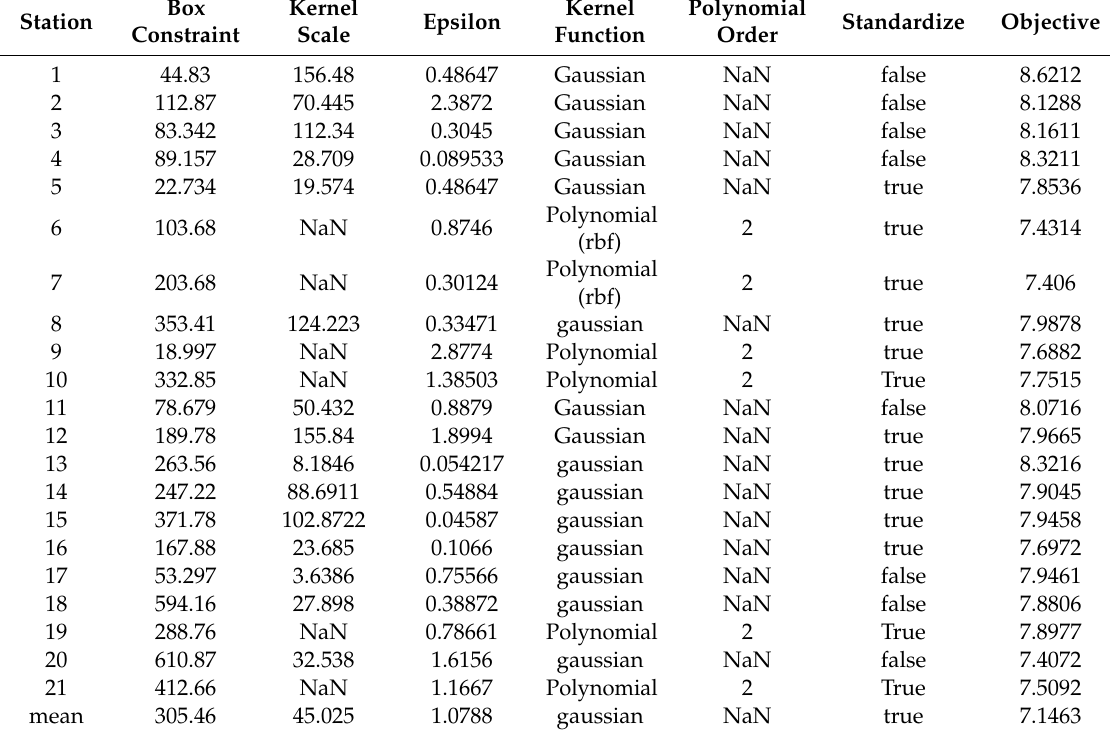
Table A3. Optimal results of Bayesian hyper-parameter optimization of SVR in this region.